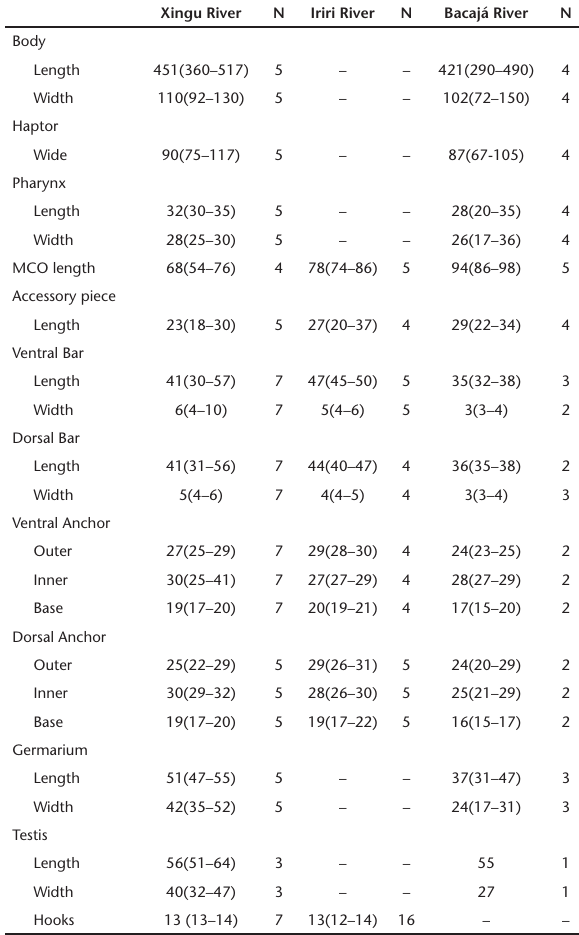
Table 5. Comparative measurements (μm) of specimens of Cos- metocleithrum akuanduba sp. nov. from the gills of Hassar gabiru from three